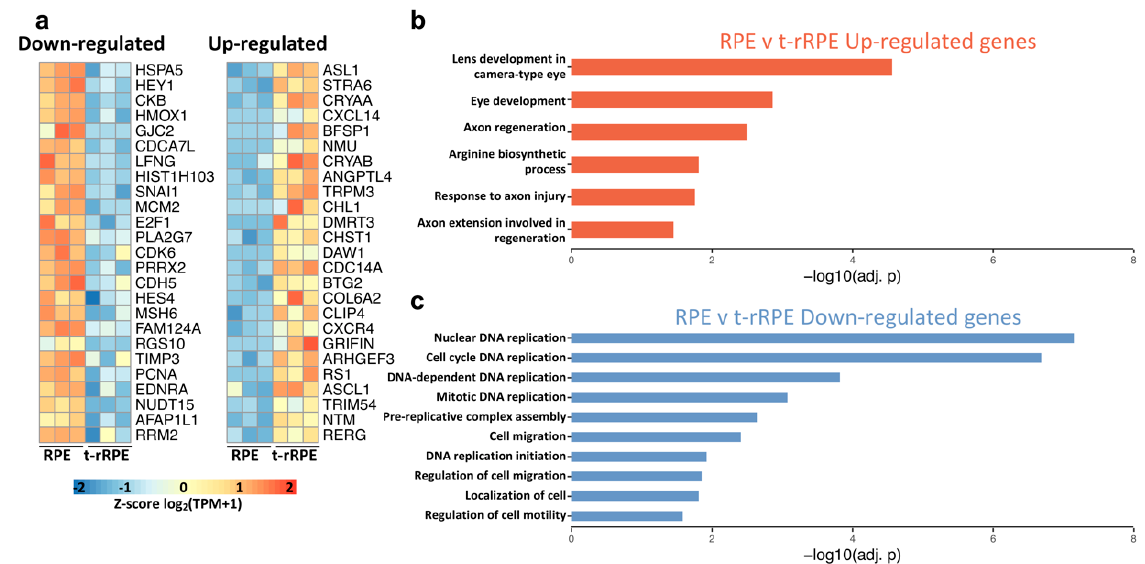
Figure 2. Injury-responsive DEGs control cell cycle dynamics and initiate reprogramming in the early t-rRPE. ( a ) Top 25 up- and down-regulated genes, as ranked by adjusted p -value, are displayed in heatmaps. Values are row-normalized. ( b ) Pathway enrichment analysis of up-regulated genes. ( c ) Down-regulated genes were used for pathway enrichment analysis, using the same criteria as in ( b